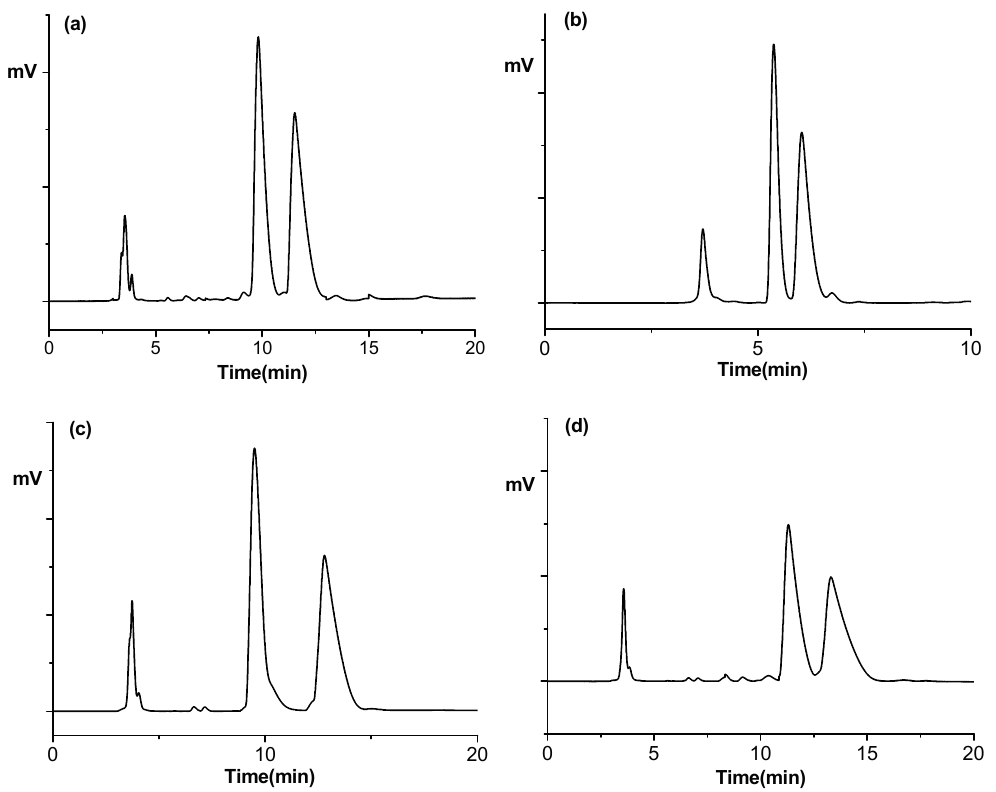
analogues; ( b ) 10 ; ( c ) 12 ; and ( d ) 13 with the use of a mobile phase consisting of methanol–acetonitrile–trifluoroacetic acid–triethylamine at a ratio of 80/20/0/1/0.5 (v/v/v/v). Flow rate: 0.5 mL/min. Detection: 254 nm UV. Temperature, 20 °C.